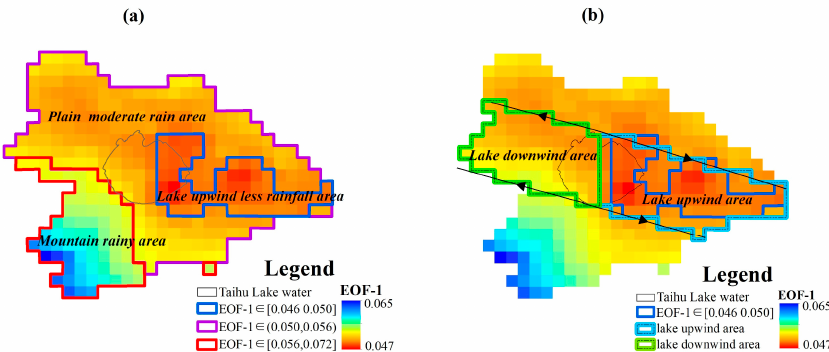
Figure 9. Divisions based on EOF-1 value and wind direction at 0.1° × 0.1° grid scale. ( a ) Divisions based on EOF-1 value; ( b ) Divisions based on wind direction. Table 3. Correlation coe ffi cient between precipitation spatial distribution of di ff erent EOF-1